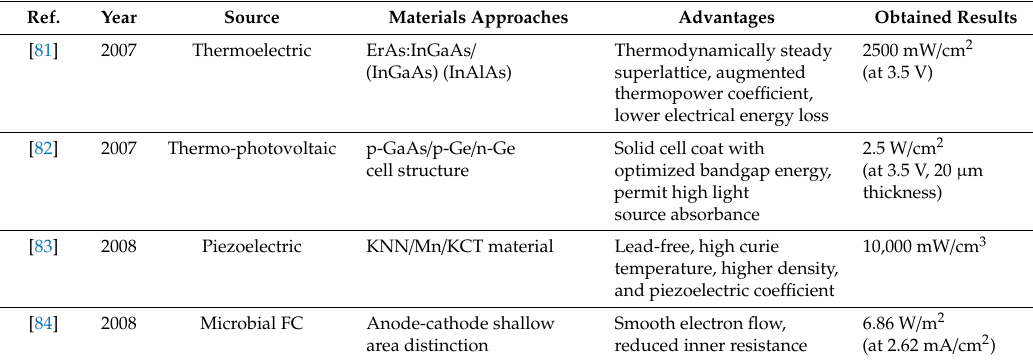
Table 1. Achievements of material approaches for energy harvesting.